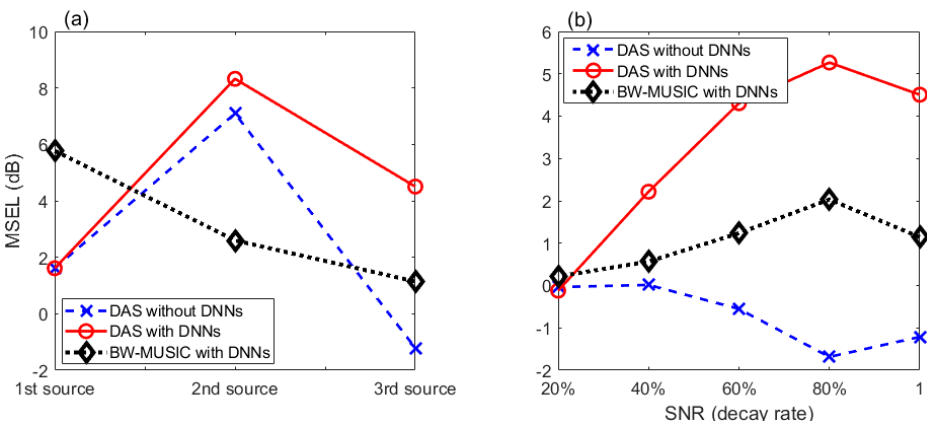
Figure 10. MSEL results of the three sources ( a ) and the effective SNR ranges ( b ).